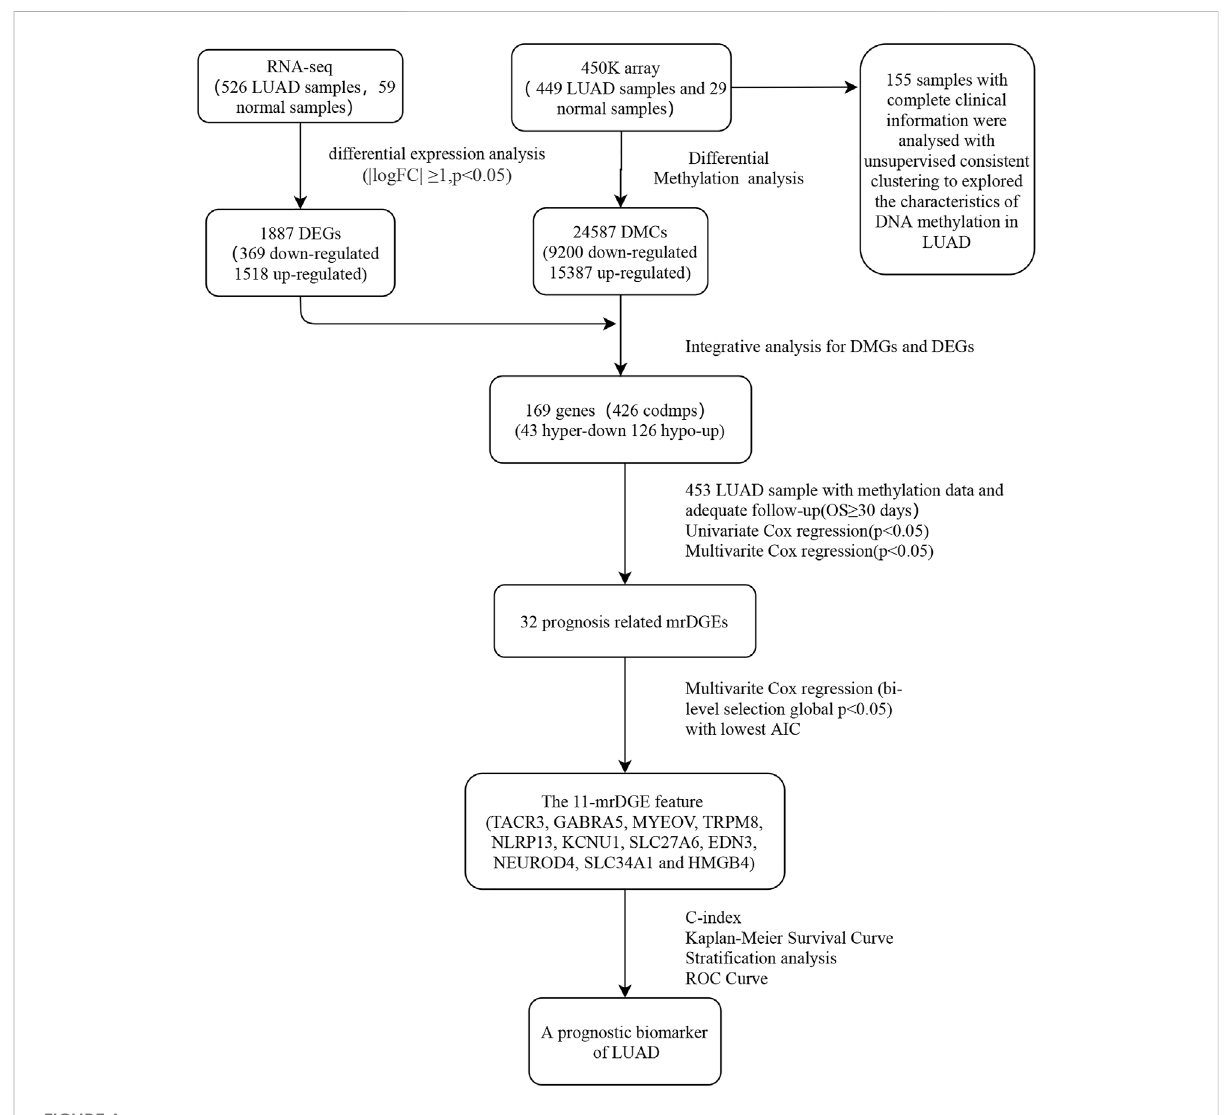
FIGURE 1 Flow chart for obtaining and verifying methylation